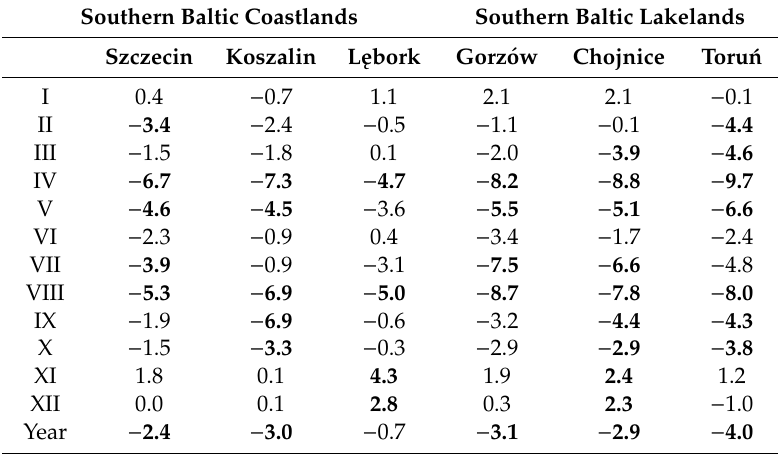
Table 5. Monthly and annual values of relative humidity (%) changes calculated from linear regression equations, 1952–2018 (bold font indicates values that are statistically significant at a level of 0.05) (calculated based on data obtained from the Polish Institute of Meteorology and Water Management—National Research Institute